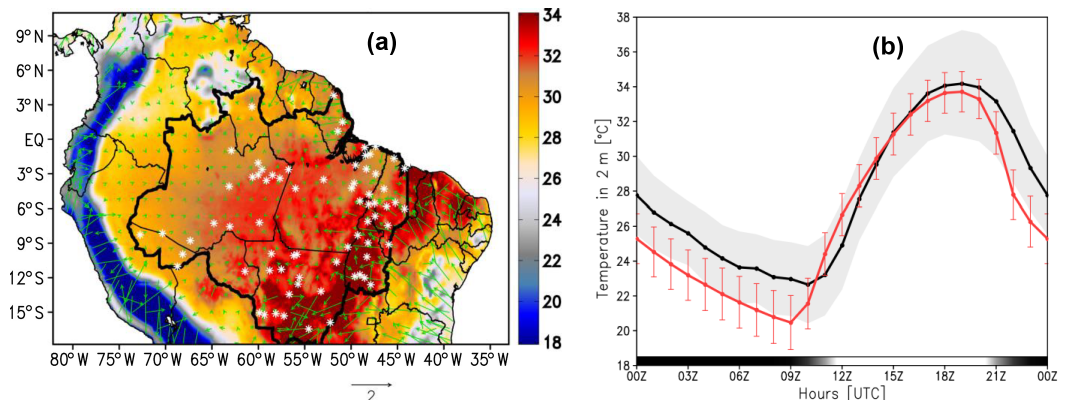
Figure 3. (a) Spatial distribution of mean 2m temperature and 10m wind field from the model during September 2010 at 16:00UTC. The LBAR and the locations of 72 near-surface measurement ground stations used to evaluate the model 2m temperature are depicted in the map with white asterisks. (b) Mean diurnal cycle of 2m temperature ( ◦ C) observed in the 72 near-surface ground stations (black line) and from the model grid point nearest the respective station (red line). The standard deviation (shaded gray) and the mean observed temperature values were calculated using measurements at the 72 observational stations, while the model standard deviation (red bars) and mean temperature were calculated using the model temperatures at the grid boxes corresponding to the locations of the 72